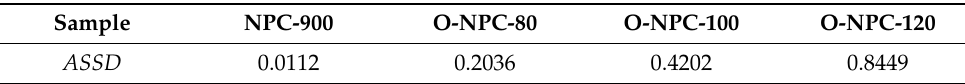
Table 2. Calculation results of active site density.